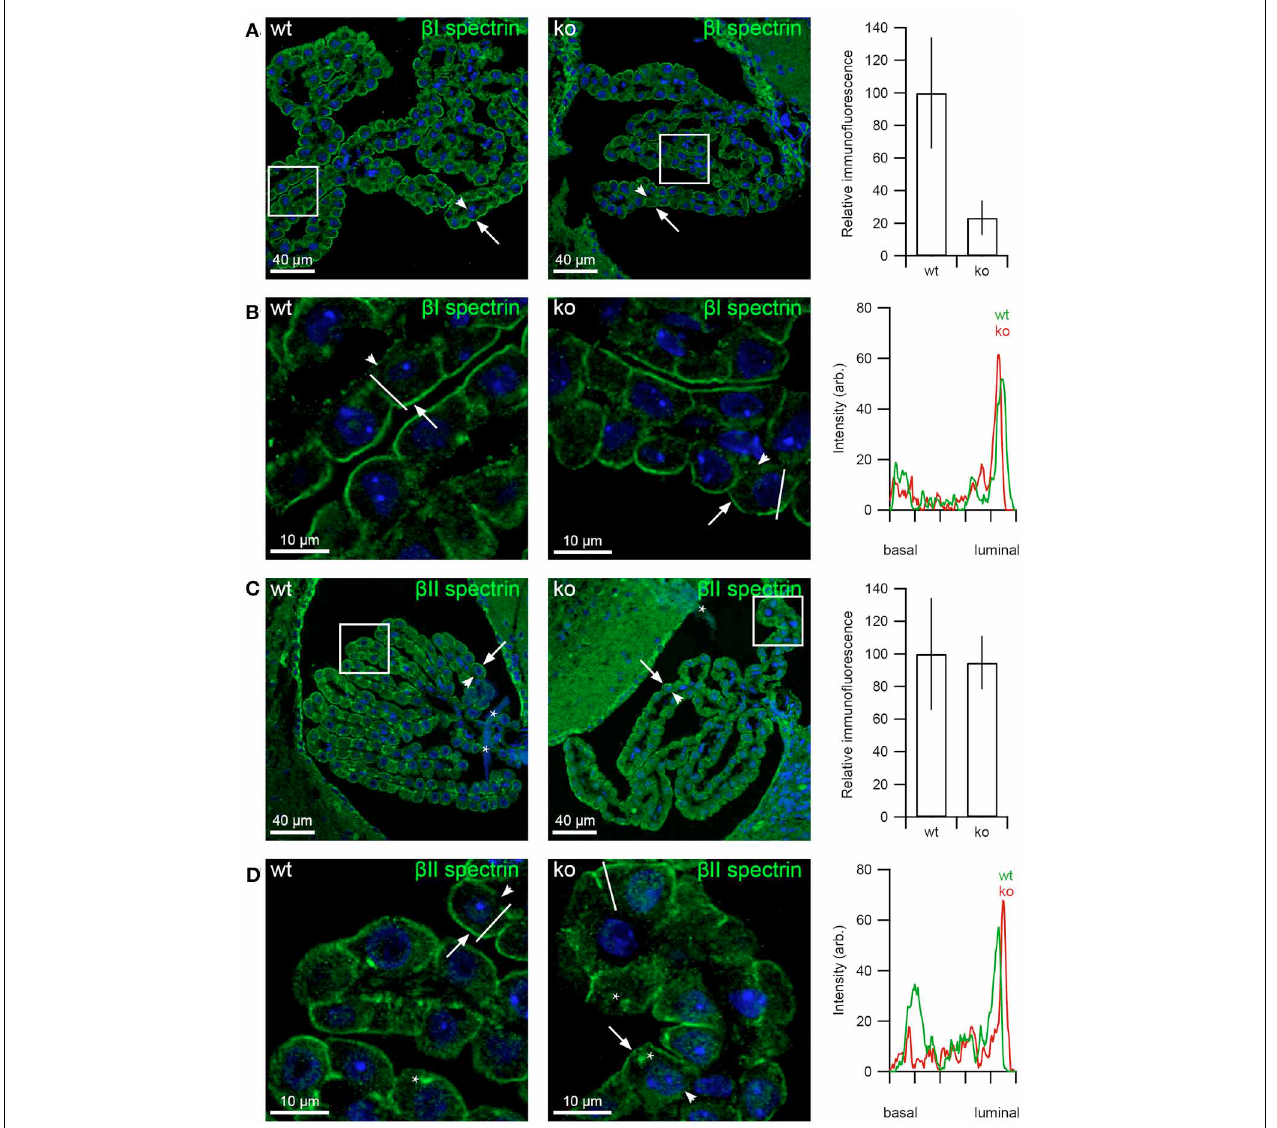
FIGURE 8 | Altered β -spectrin expression in CPE from slc4a10 ko mice. Mouse brain sections were immunostained for β I- and β II-spectrin. (A) Immunolabeling for β I-spectrin in slc4a10 wt and ko CPE, as indicated. Bar graph on the right show the semi-quantitation of the respective immunofluorescence in slc4a10 wt and ko mouse CPE (wt: n = 5, ko: n = 4). (B) High magnification micrograph of the subcellular β I-spectrin staining pattern. The graph is a linescan of the cellular fluorescence signal from the basal to the luminal domain. The analyzed line is indicated on the micrographs. (C) Immunolabeling for β II-spectrin in slc4a10 wt and ko, as